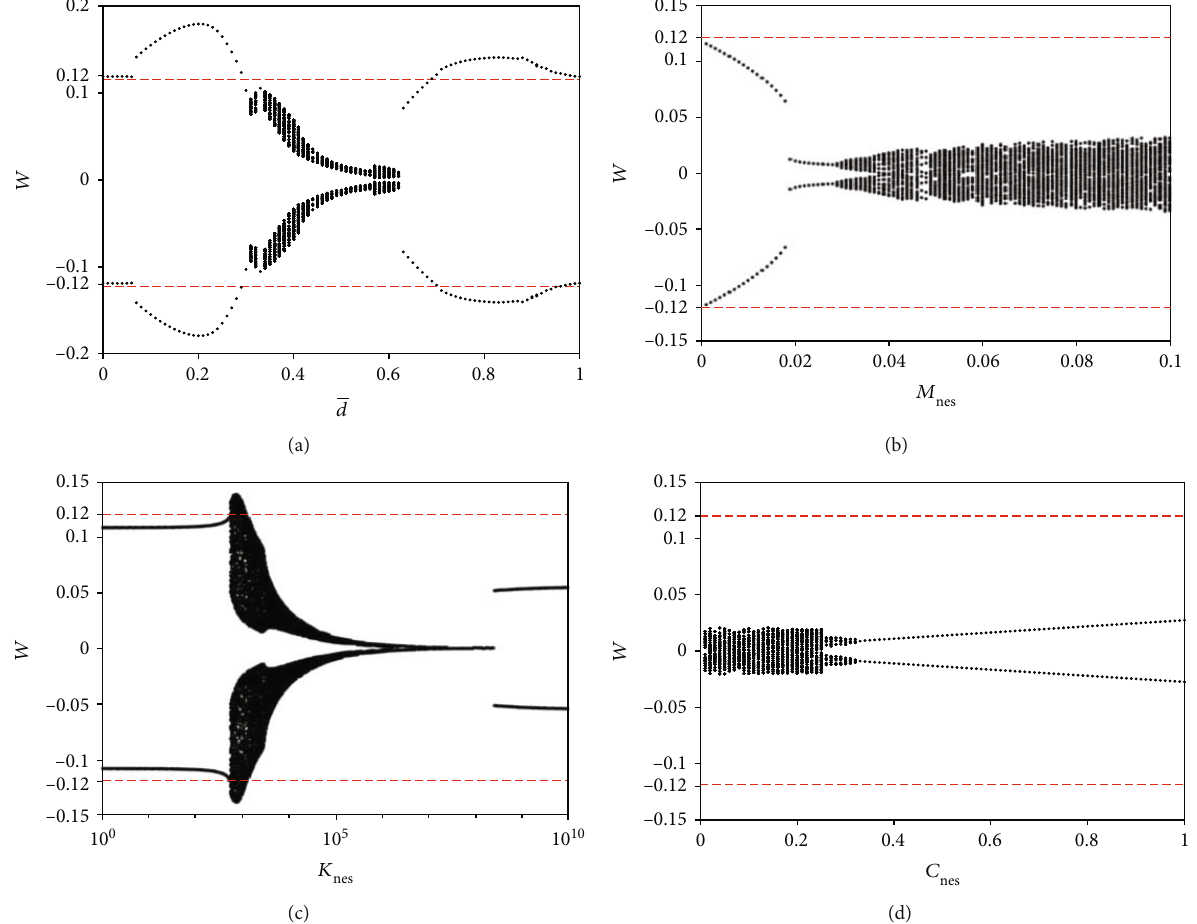
Figure 13: Bifurcation diagrams for di ff erent NES parameters: (a ) location, (b ) mass, (c) sti ff ness, and (d)